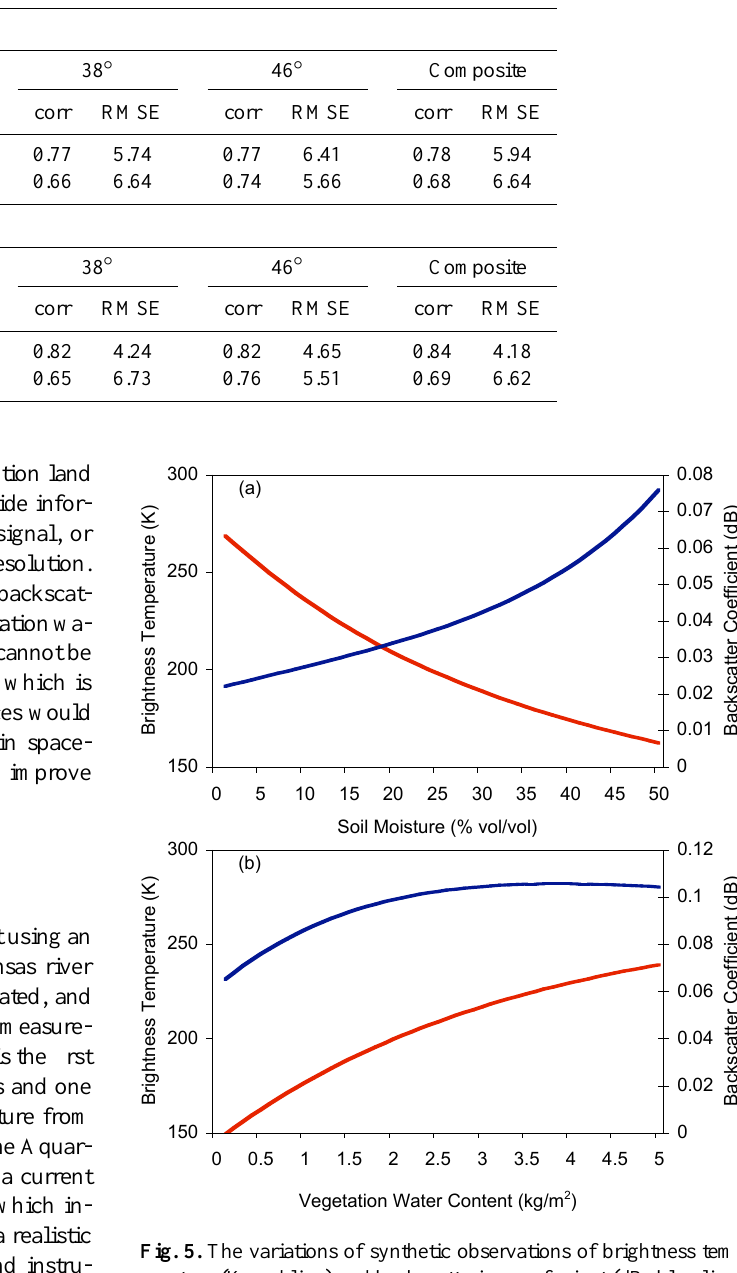
Table 1. The correlation coefficient (corr) and root mean square error (RMSE, %vol/vol) between the truth and soil moisture retrievals at incidence angles of 29 ◦ , 38 ◦ and 46 ◦ from synthetic radiometer and scatterometer measurements, and their respective composite from September 2002 to September 2003 for (a) the entire domain and (b) the entire domain but the grid cells with vegetation water content higher than 3kgm − 2 screened out.